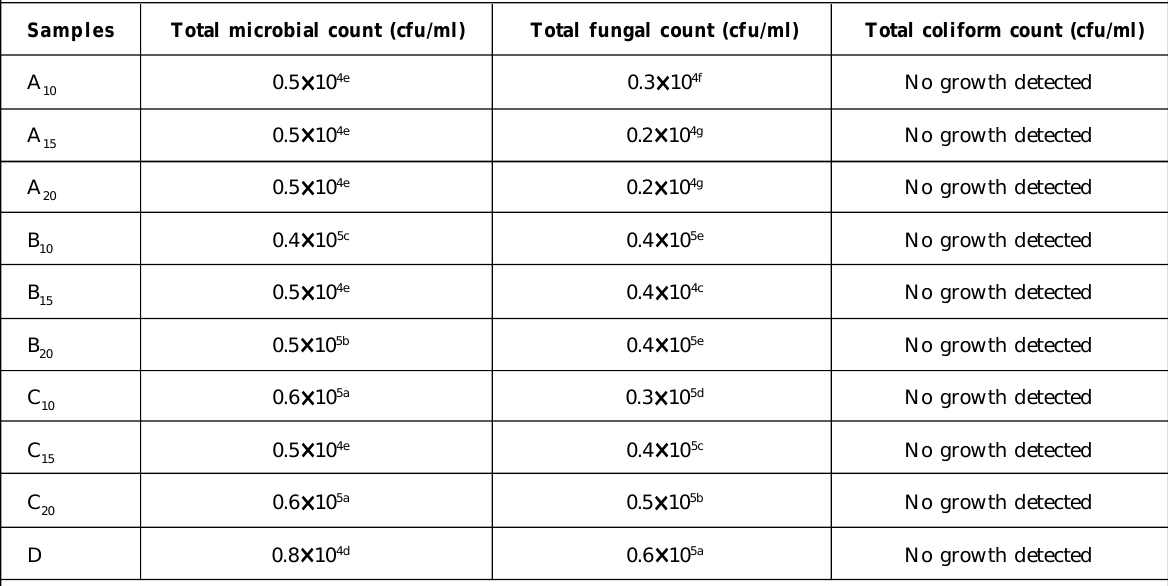
Note: Each count is recorded as the total number of microbial colonies formed per 1 ml of yogurt sample